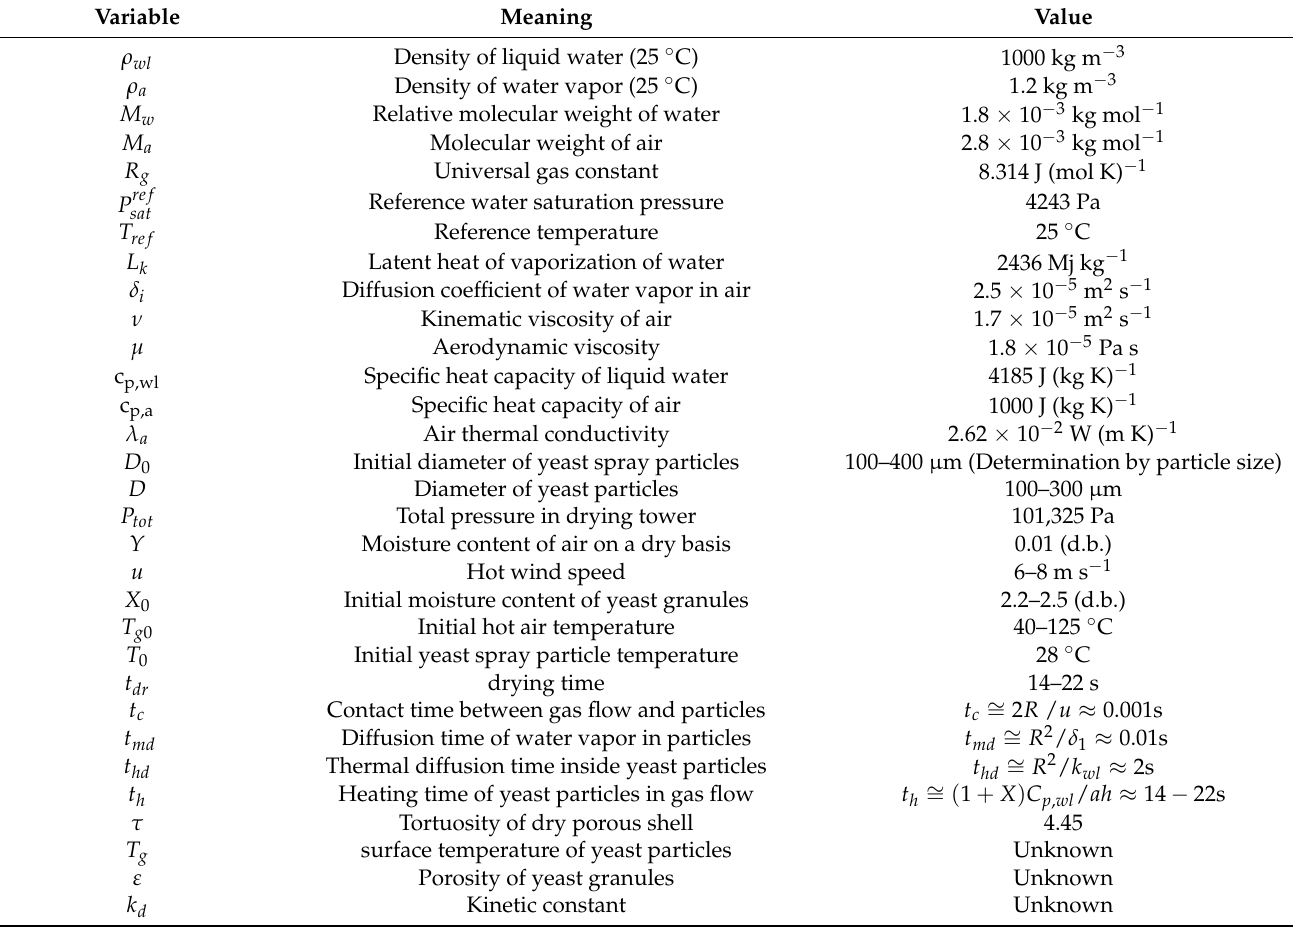
Table 2. Meanings and values of modeling